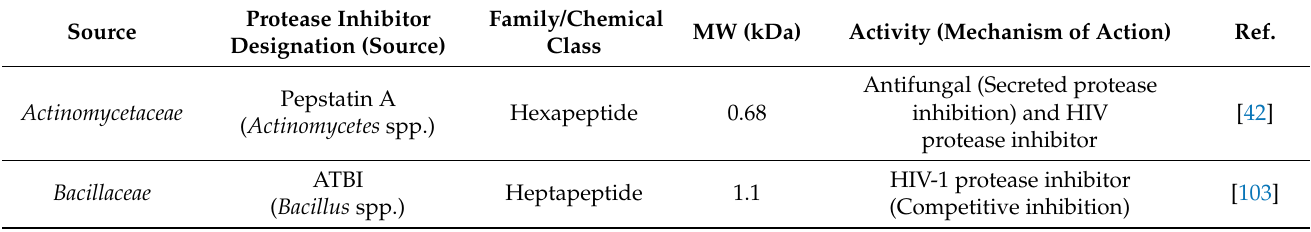
Table 3. Protease inhibitors derived from bacteria with antimicrobial